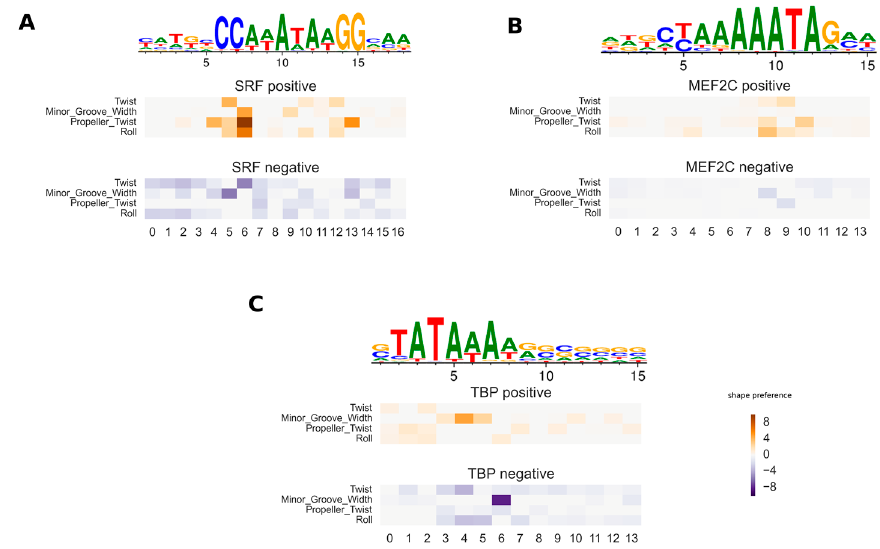
Figure 1. Shape feature preferences for Serum Response Factor (SRF), Myocyte Enhancer Factor 2C (MEF2C), and TATA-Box Binding Protein (TBP). The heatmaps show the preference for each shape feature at each binding position (the inferred d f matrix), with the preference for low and high feature values in blue and orange, respectively. The shape preferences are split into positive and negative parts accordingly. Grey color represents weaker preference. The position-specific weight matrix (PWM) logos of transcription factors (TFs) are shown above the shape preference heatmaps.